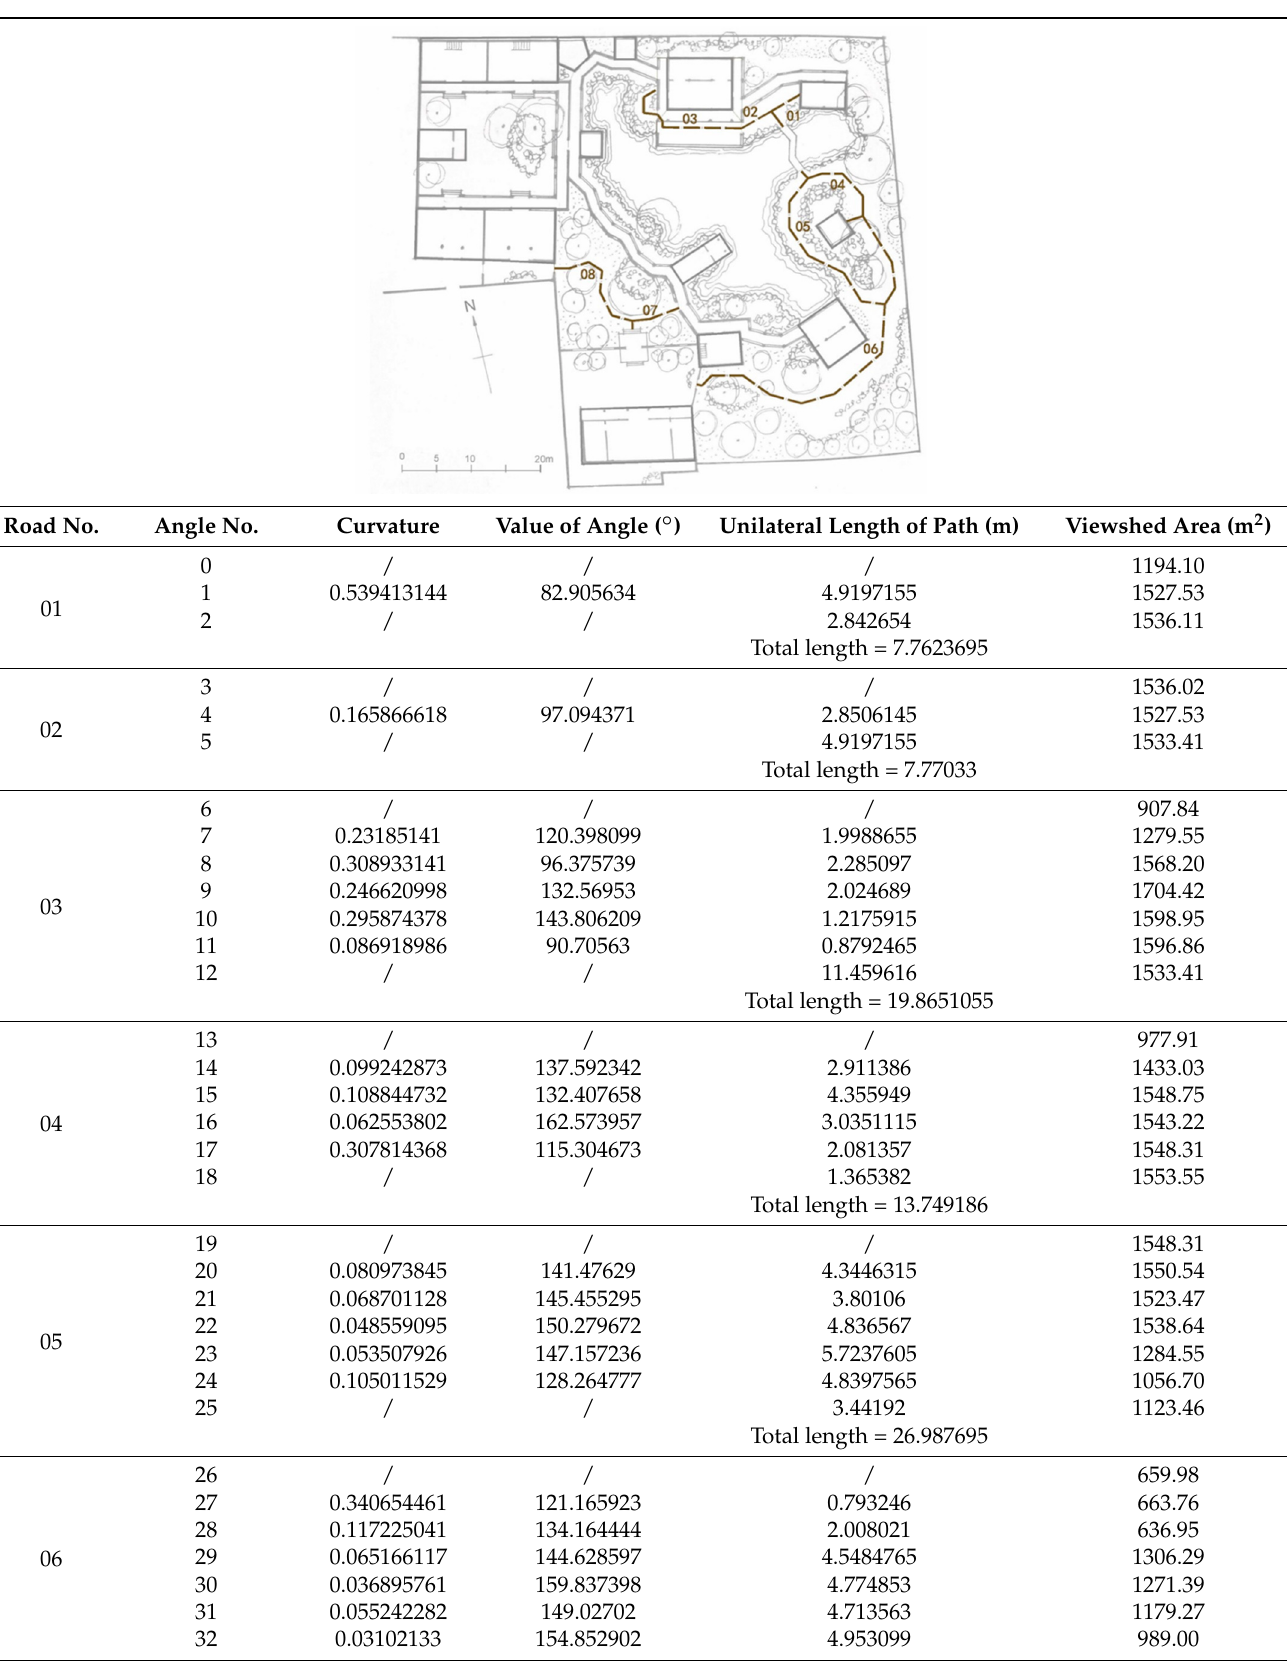
Table A8. Retreat and Reflection Garden, garden path.